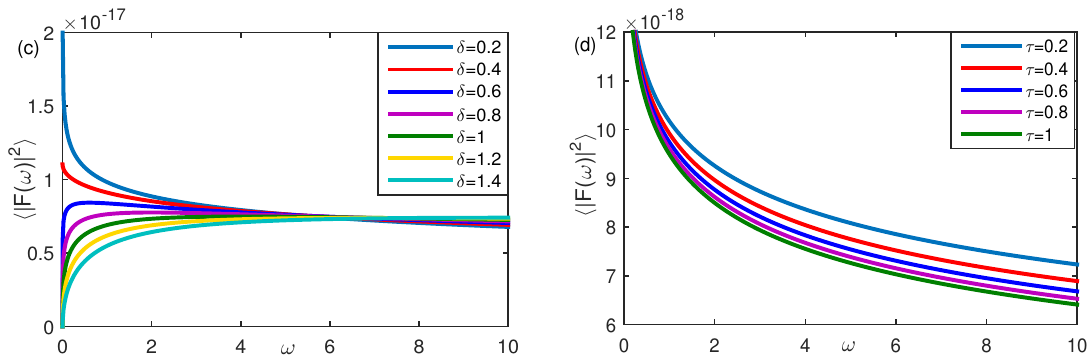
Figure 1. Spectrum of three-parameter ML noise. ( a ) Various α with β = 0.5, δ = 0.4, τ = 0.5; ( b ) various β with α = 0.5, δ = 0.4, τ = 0.5; ( c ) various δ with α = 0.5, β = 0.2, τ = 0.5; ( d ) various